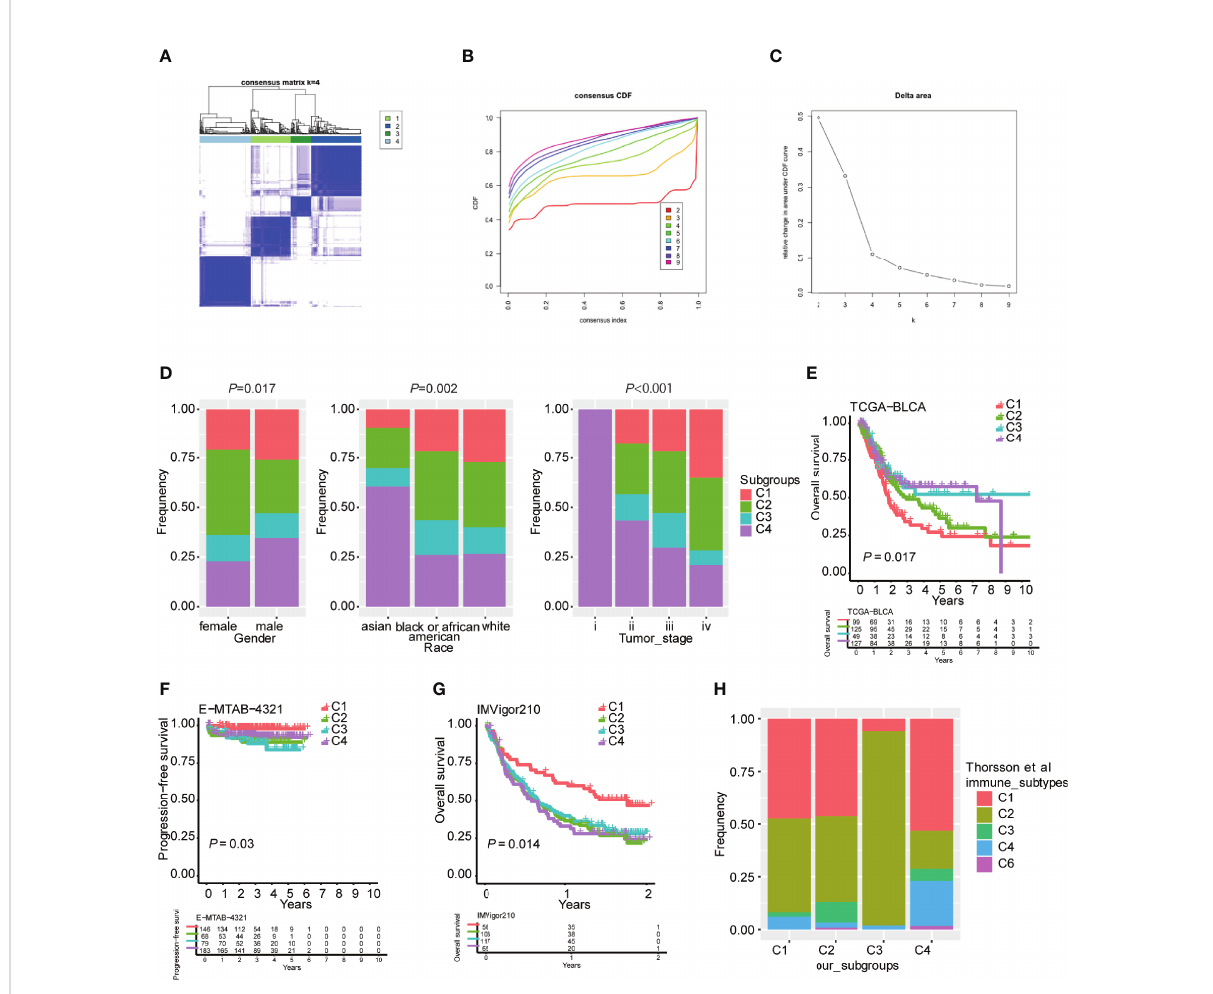
FIGURE 1 Robust classi fi cation of distinct immune subtypes of bladder urothelial carcinoma. (A) Consensus clustering analysis of bladder urothelial carcinoma patients. (B) Cumulative distribution function (CDF) curve of the training cohort. (C) CDF delta area curve of the training cohort. (D) Distribution of immune subtypes according to sex, race, and tumor stage. (E) Kaplan plot of overall survival in TCGA-BLCA cohort. (F) Kaplan plot of progression-free survival in the E-MTAB-4321 cohort. (G) Kaplan plot of overall survival in the IMVigor210 cohort. (H) The overlap between our four immune subtypes and Thorsson ’ s six